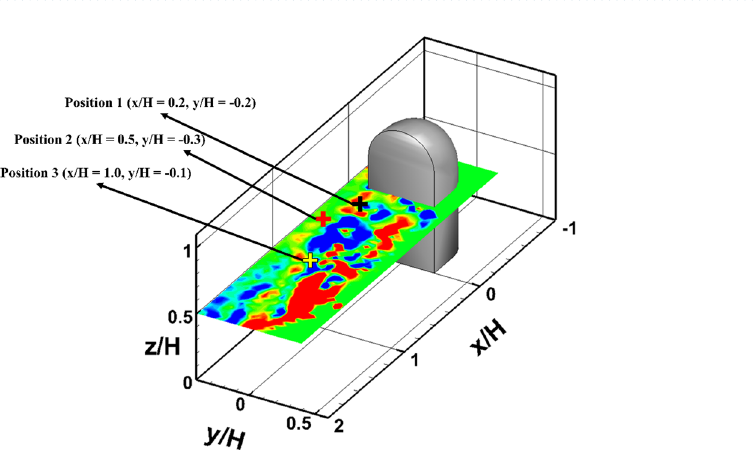
Figure 11. Comparison of the instantaneous 3D streamwise vortex structures between the raw and predicted data. ( a , b ) Raw data at t1, t2; ( c , f ) spatial enhancement by ANFIS at t1, t2; ( d , e ) spatio-temporal enhancement by ANFIS.